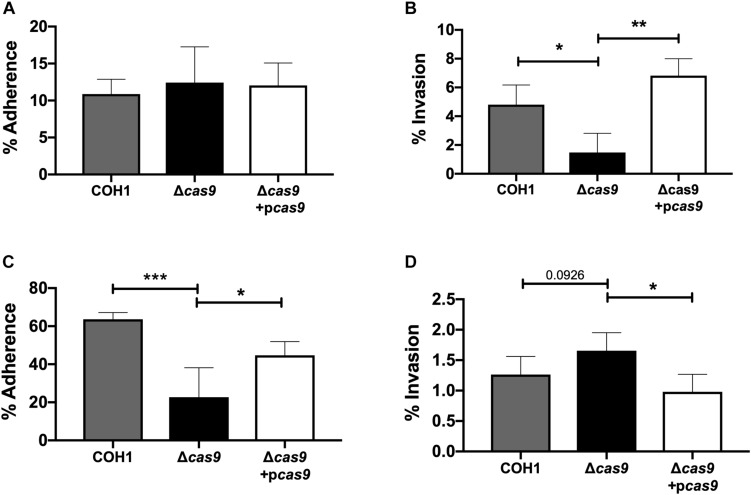
Cas9 mediates GBS interaction with host cells, in vitro. WT GBS, Δcas9 mutant, and Δcas9 + pcas9 strains were used to assess (A) adherence to hCMEC, (B) invasion of hCMEC, (C) adherence to hVEC, and (D) invasion of hVEC. All data are represented as percent CFU recovered of the initial inoculum and were performed in technical replicates of n = 4. Each plot is representative of three individual experiments. One-way ANOVA with Sidak’s multiple comparisons, with comparisons made to the Δcas9 mutant, ∗p < 0.05; ∗∗p < 0.01; ∗∗∗p < 0.001.